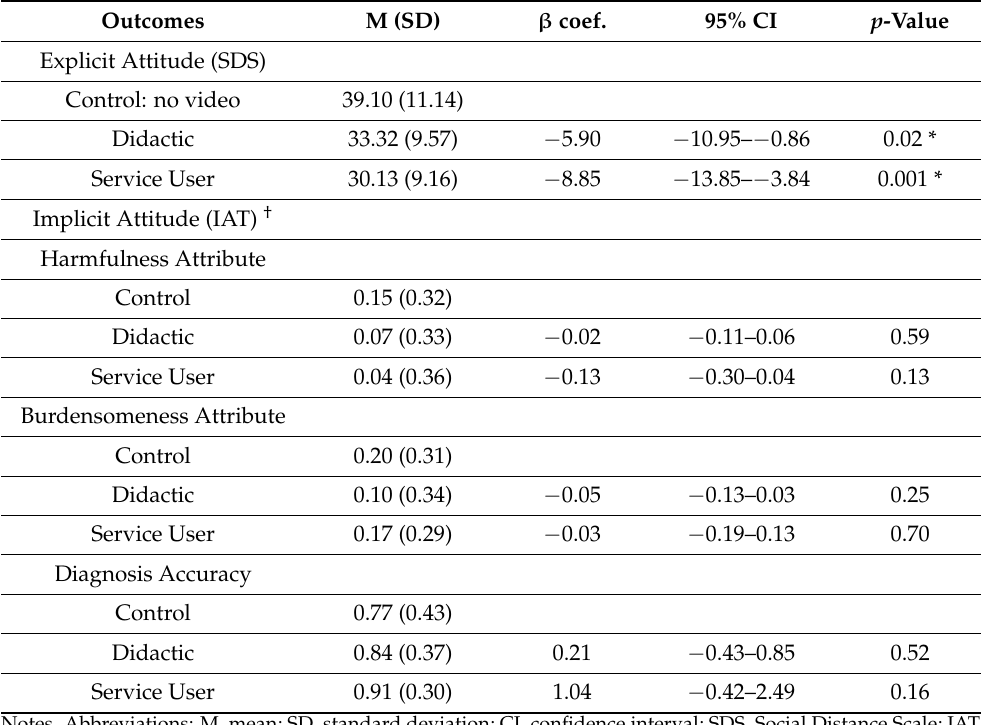
Table 3. Bivariate analyses of the effects of didactic and service user video interventions versus no video control on attitudes and depression